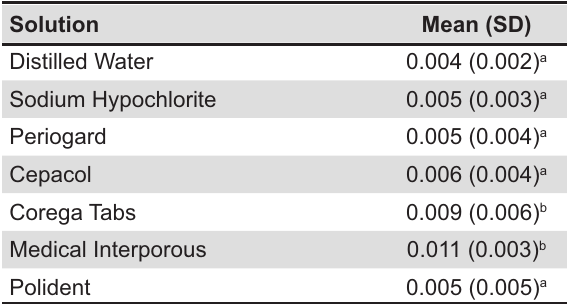
Table 1- Means and standard deviation (SD) of weight